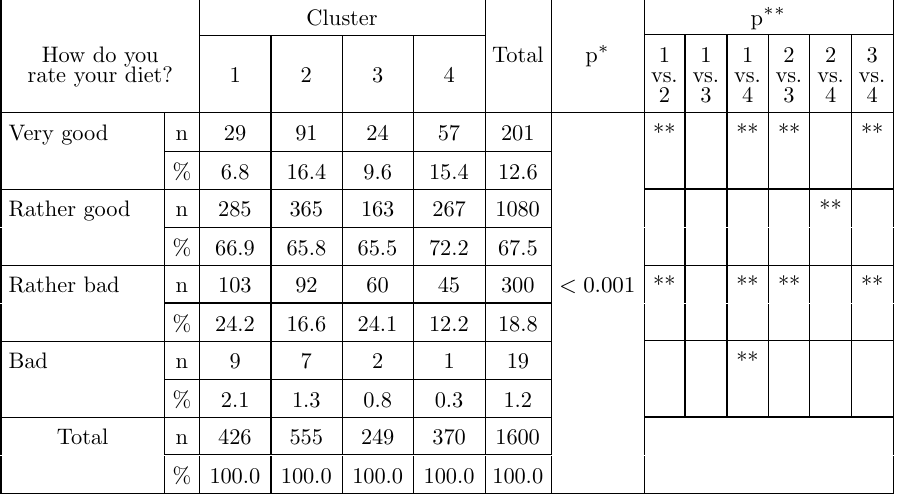
Table 7. Subjective assessment of diet in the opinion of the surveyed students in separate clusters Cluster p ∗∗ How do you Total p ∗ 1 1 1 2 2 3 rate your diet? 1 2 3 4 vs. vs. vs. vs. vs. vs. 2 3 4 3 4 4 Very good n 29 91 24 57 201 ** ** ** ** % 6.8 16.4 9.6 15.4 12.6 Rather good n 285 365 163 267 1080 ** % 66.9 65.8 65.5 72.2 67.5 Rather bad n 103 92 60 45 300 < 0 . 001 ** ** ** ** % 24.2 16.6 24.1 12.2 18.8 2 1 19 ** % 2.1 1.3 0.8 0.3 1.2 Total n 426 555 249 370 1600